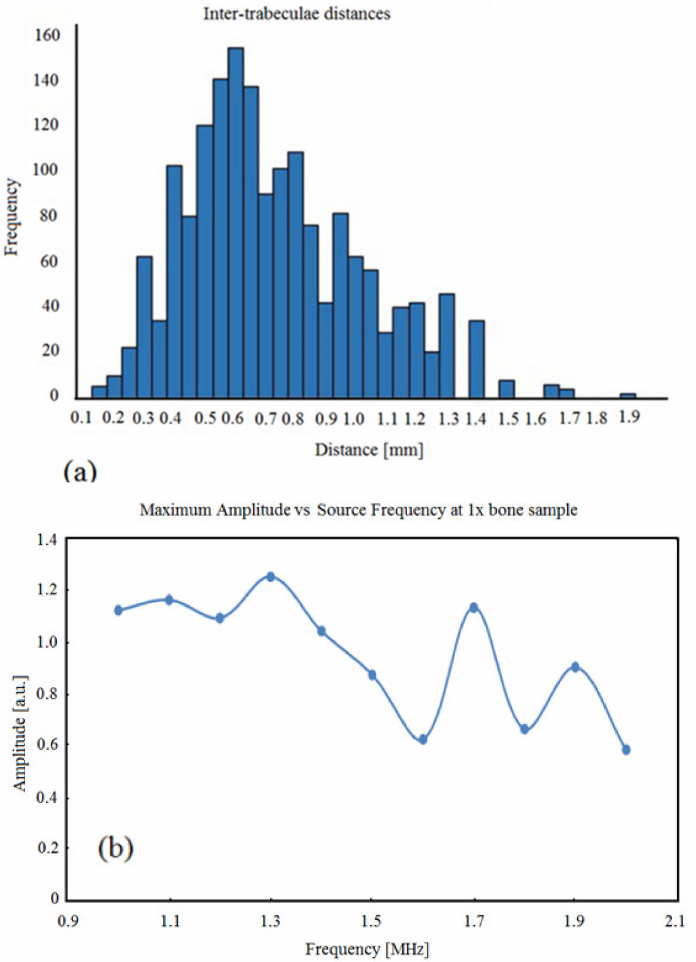
Figure 3. ( a ) Histogram of inter-trabeculae distances (mm) in the 25 slices of bone used for simulation; ( b ) maximum amplitude vs. source frequency for the original bone